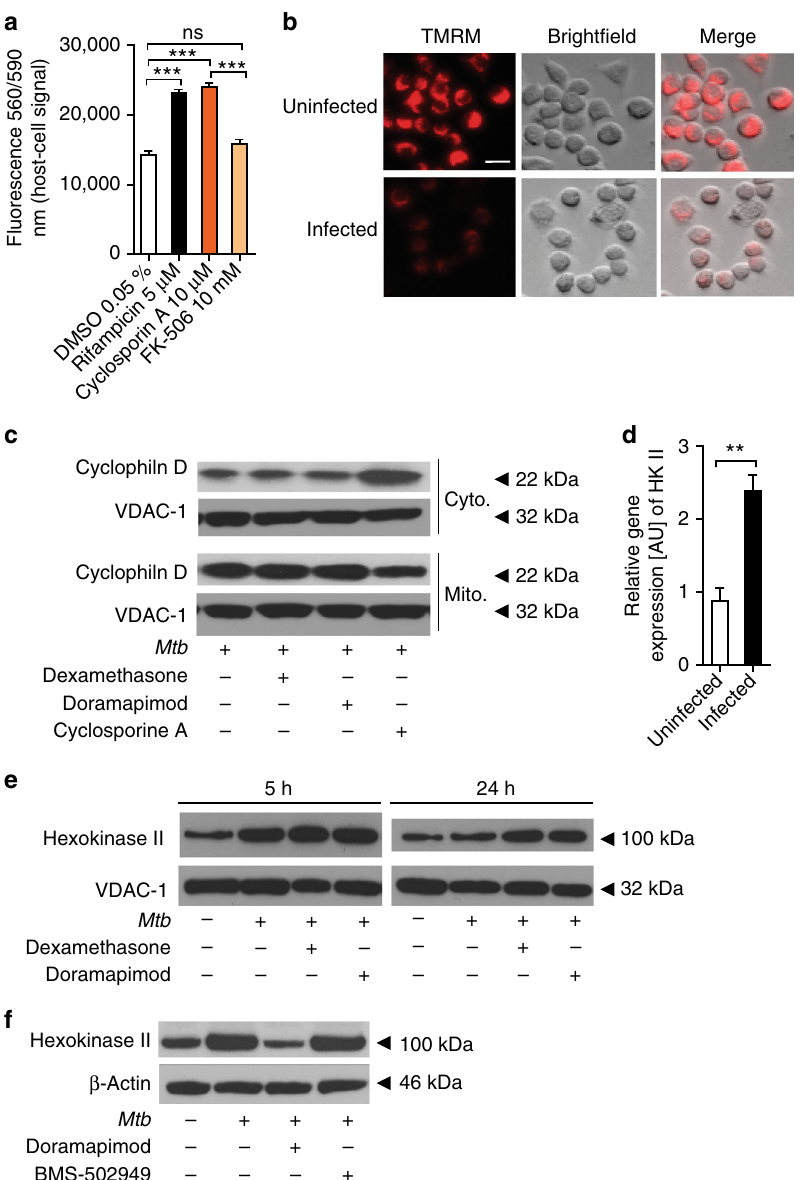
Fig. 5 Mtb triggers p38 MAPK-dependent necrosis by opening of the mitochondrial permeability transition pore (mPTP). a Protective effect of cyclosporine A (CsA; 10 µ M) in Mtb- infected MRC-5 lung fi broblasts (MOI 10). Viability was quanti fi ed 72h after infection using Prestoblue. b Fluorescence microscopy of uninfected and infected (MOI 5) J774.2 M φ stained with tetramethylrhodamine (TMRM) 48h post infection (scale bar: 100 µ m). Images are representative of two independent experiments. c Quanti fi cation of cytosolic and mitochondrial CypD following Mtb infection. MRC-5 lung fi broblasts were infected with Mtb (MOI 10), treated with dexamethasone (5 µ M), doramapimod (10 µ M), or CsA (10 µ M) and lysed for the isolation of mitochondria 5h post infection. Equal amounts of protein from the mitochondrial and cytosolic fractions were subjected to western blot analysis and the levels of CypD were measured. Voltage- dependent anion-selective channel 1 (VDAC-1) was used as a loading control. d Expression of hexokinase II (HKII) in Mtb - infected MRC-5 lung fi broblasts. Lysates were obtained 24h after infection and were analyzed by qRT-PCR. e Quanti fi ciation of mitochondrial HKII following Mtb infection. J774.2 M φ were infected with Mtb , treated with dexamethasone (5 µ M) or doramapimod (10 µ M), and mitochondria were isolated 5 and 24h post infection. Equal amounts of protein were subjected to western blot analysis and the levels of HKII were measured. VDAC-1 was used as a loading control. f Quanti fi cation of HKII in the cytosol of MRC-5 lung fi broblasts. Whole-cell lysates were obtained from infected untreated cells and from infected cells treated with doramapimod (10 µ M) or BMS-582949 (10 µ M) 48h post infection. HKII was quanti fi ed by western blot analysis using β -actin as a loading control. Images are representative of two individual experiments. Representative data from at least two experiments with multiple replicates are shown in a and d . Results are expressed as